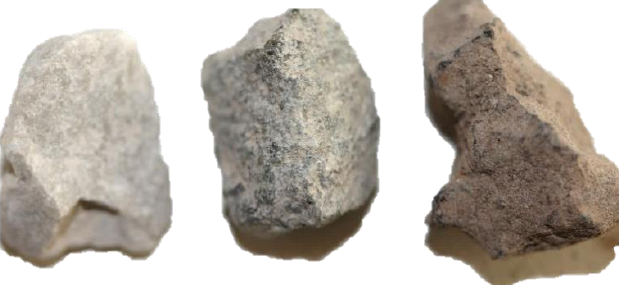
Figure 1. The appearance of the aggregate grain: dolomite, diabase and steel slag.